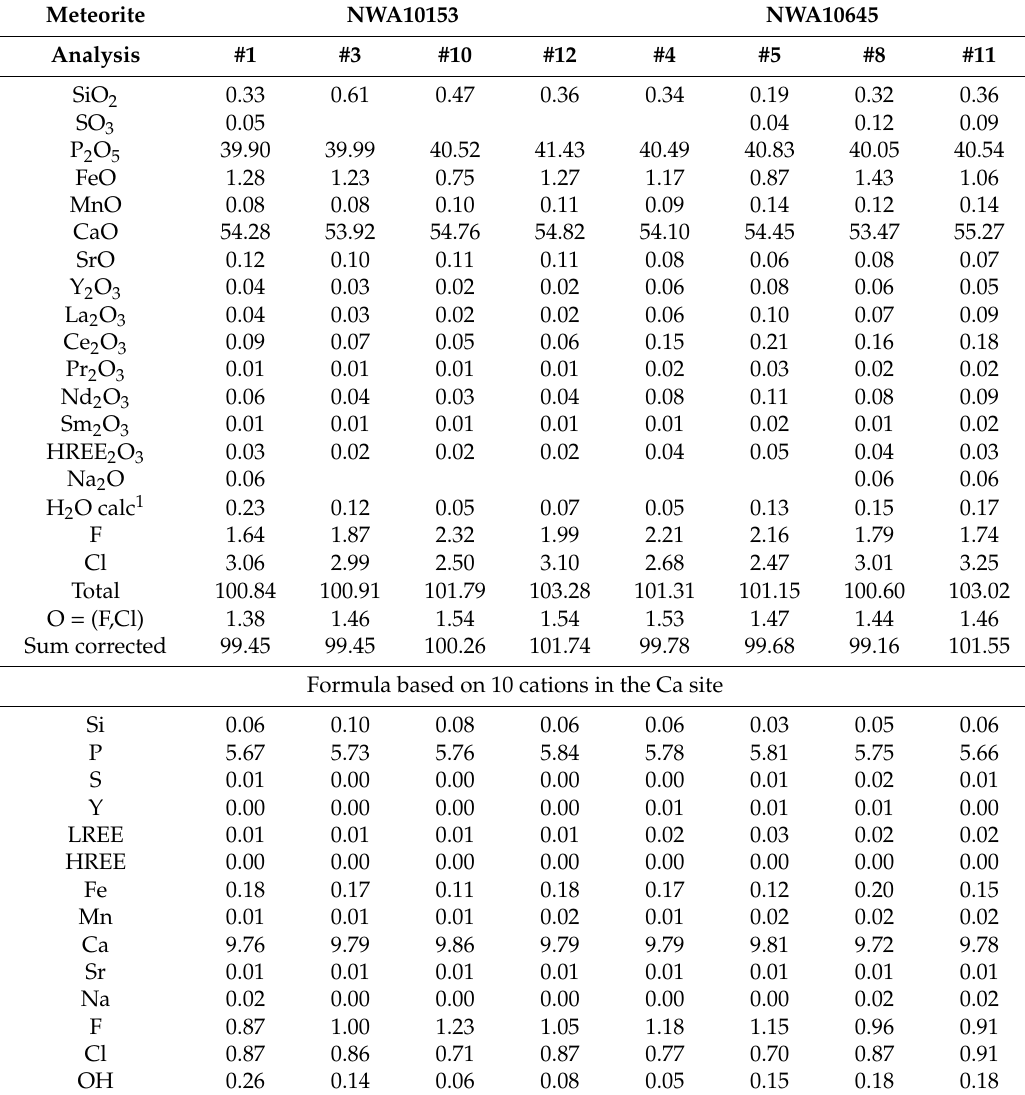
Table 1. Selected electron microprobe and laser ablation inductively coupled plasma mass spectrometry (LA-ICP-MS) analyses for apatite crystals from the NWA10153 and NWA10645 meteorites. Only the results above detection limits are